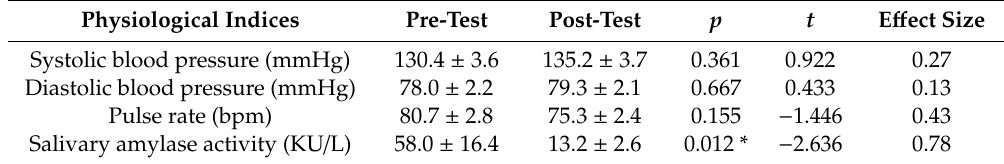
Table 4. E ff ect of Rocky Leaf Prints on physiological indices.